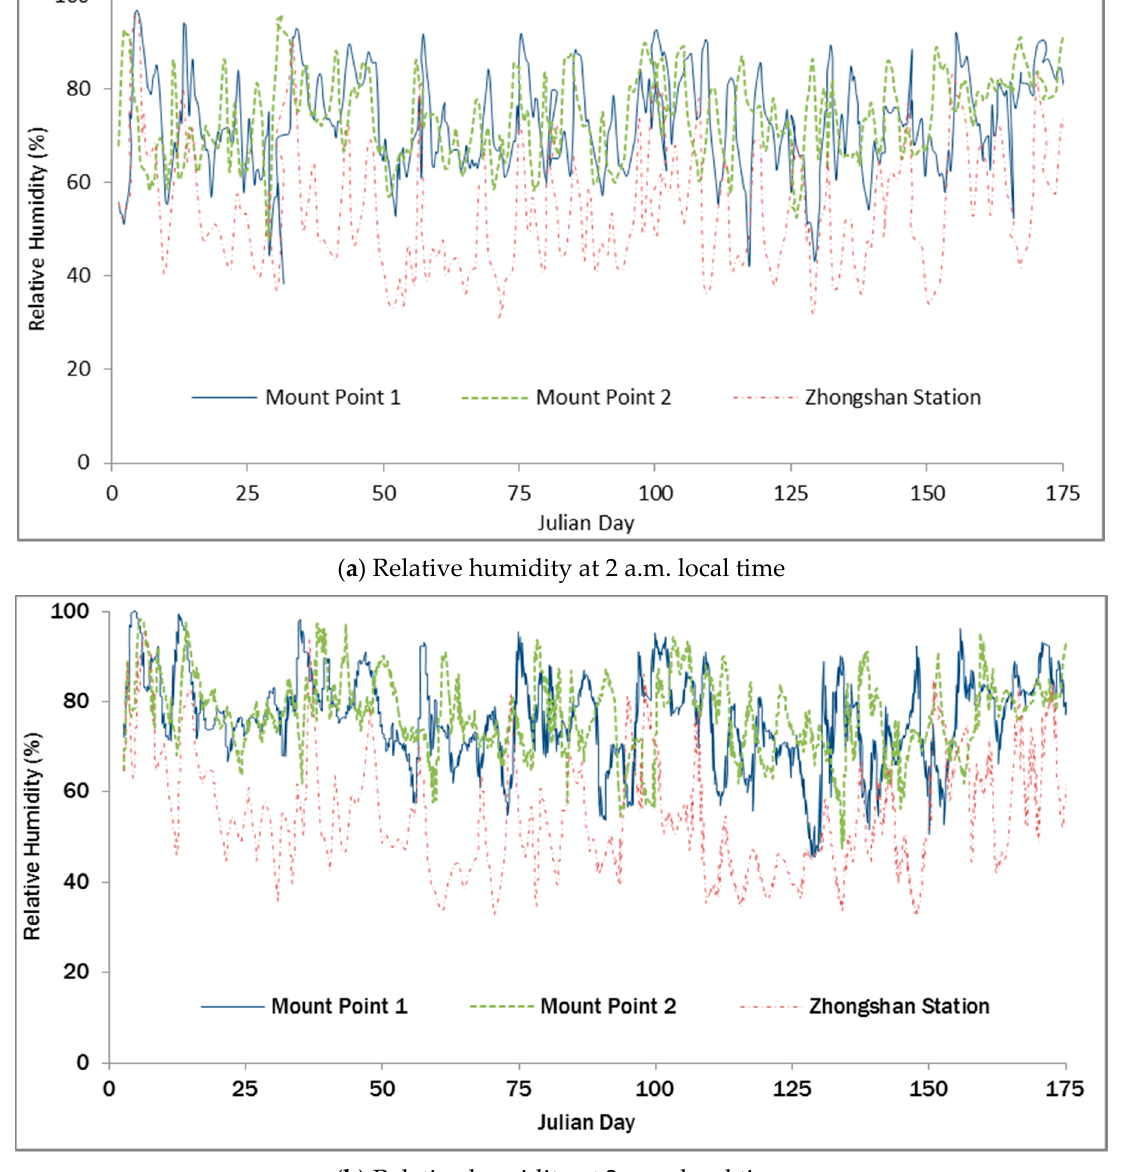
Figure 7. Comparison of the air humidity from installation points 1 and 2 and from Zhongshan Station.